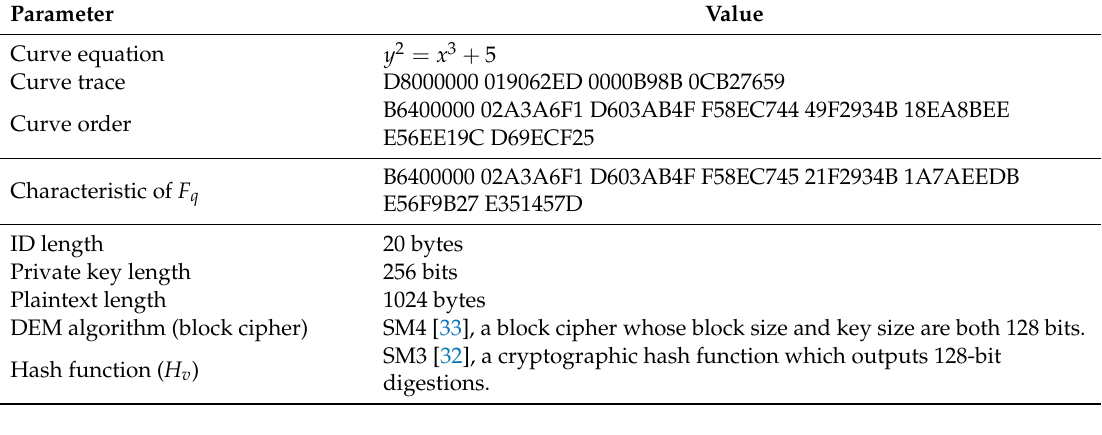
Table 1. Device configurations.